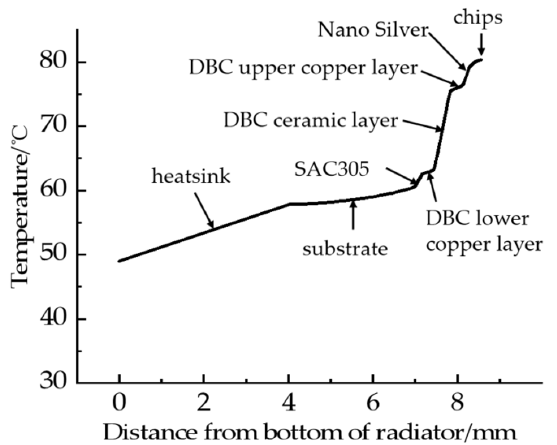
Figure 9. Temperature distribution along the longitudinal direction of the profile.